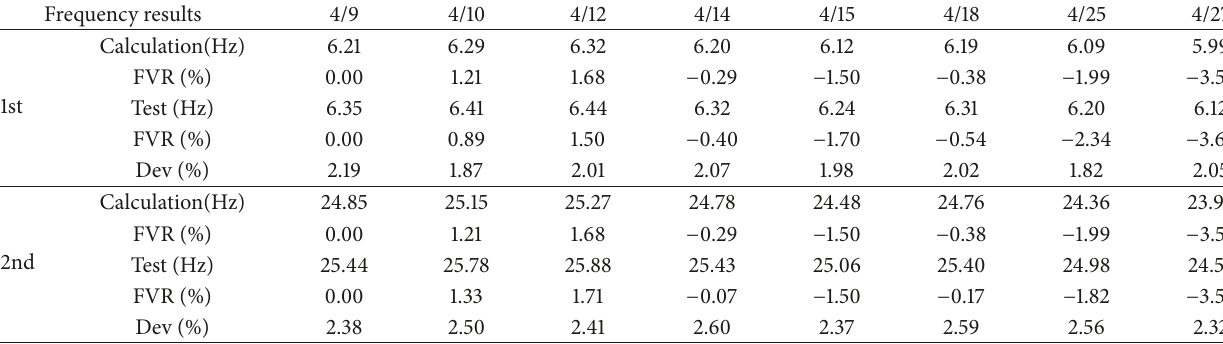
Table 4: Test and calculation frequencies at different